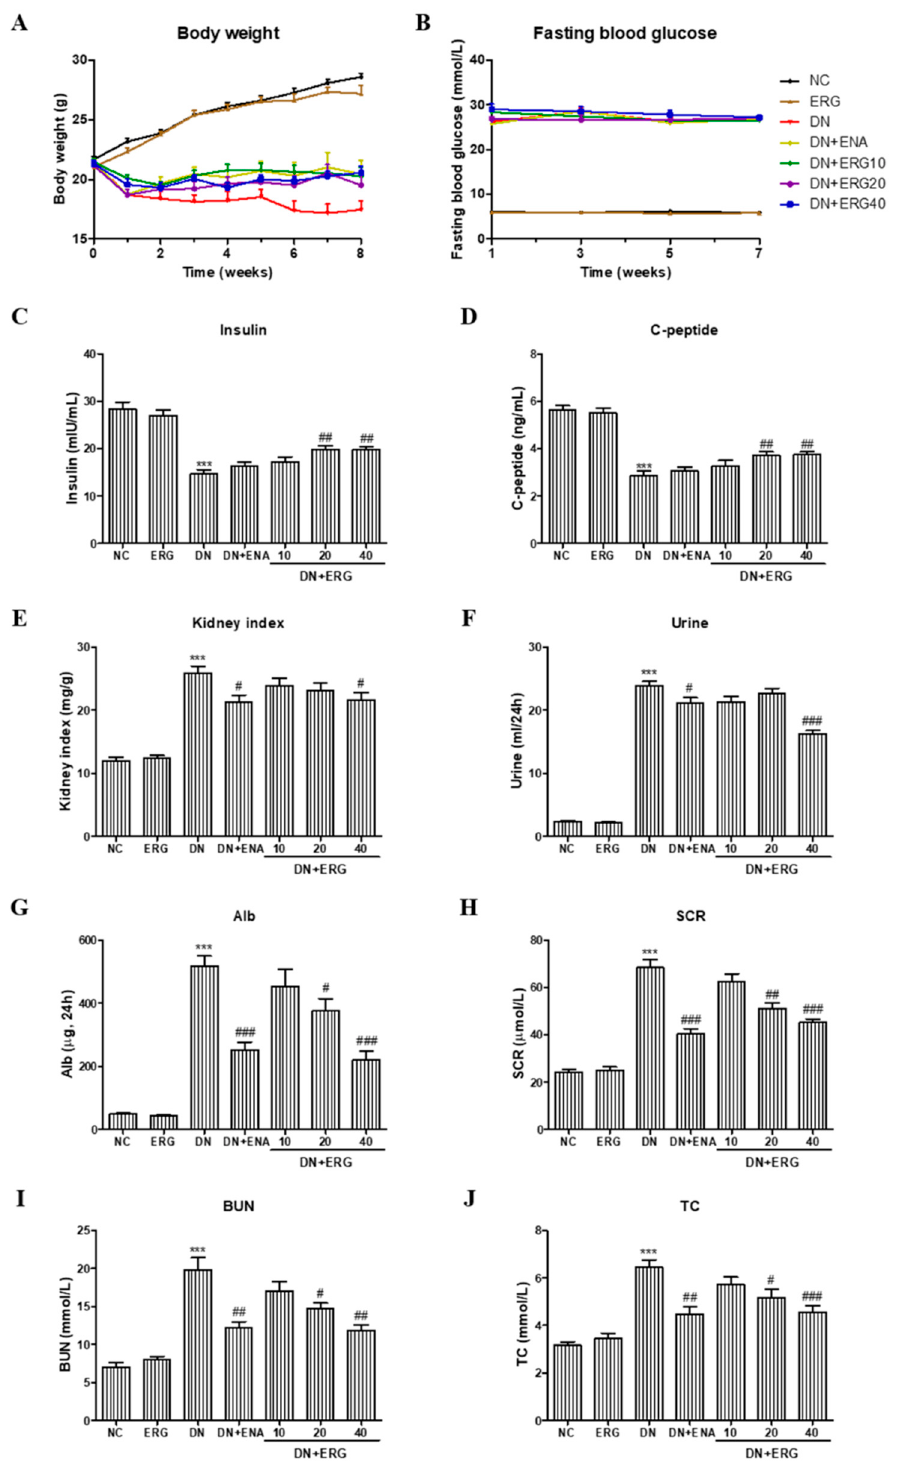
Figure 2. Effects of ergosterol on body weight, fasting blood glucose, serum insulin, C-peptide, and renal functional parameters in streptozotocin (STZ)-induced diabetic mice. ( A ) Body weight, ( B ) fasting blood glucose, ( C ) serum insulin, ( D ) C-peptide, ( E ) kidney index, ( F ) 24-h urine volume, ( G ) Alb, ( H ) SCR, ( I ) BUN, and ( J ) TC. Alb: 24-h urinary albuminuria; SCR: serum creatinine; BUN: blood urea nitrogen; TC: total cholesterol; NC: normal control; DN: diabetic nephropathy model induced by STZ; ENA: positive control, 1.5 mg/kg/day enalaprilat administration; ERG10, ERG20, ERG40: 10, 20,